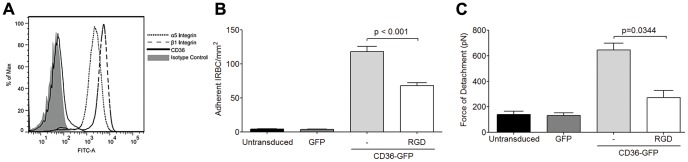
Adhesion of IRBC on the endothelial cell line HMEC-1.(A) Expression of the integrins α5 and β1 but not CD36 on HMEC-1. Results are representative of 3 independent experiments. (B) Adhesion of IRBC to untransduced, GFP-transduced and CD36-GFP transduced HMEC-1 (n = 3). (C) Force of detachment for IRBC on GFP-transduced and CD36-GFP transduced HMEC-1 (n = 3).